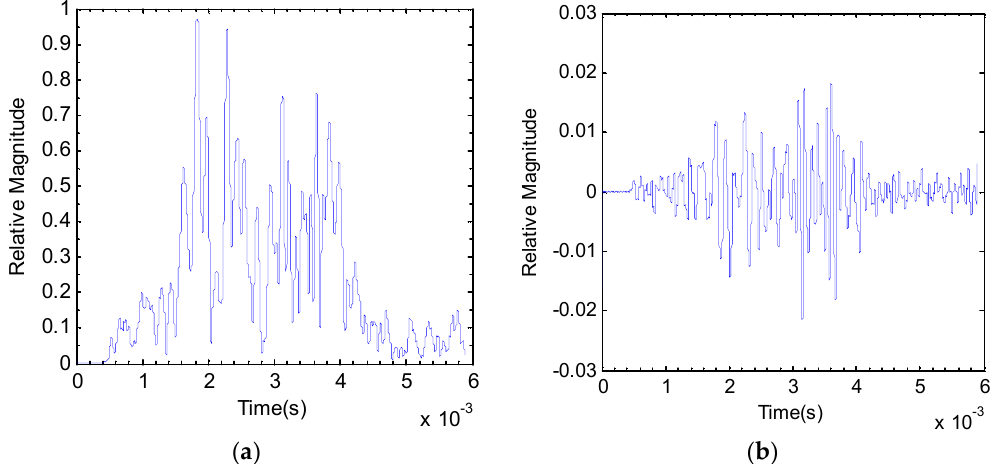
Figure 6. ( a ) Echo envelope with LFM 20–40 kHz frequency; ( b ) gradient of the echo envelope from ( a ).